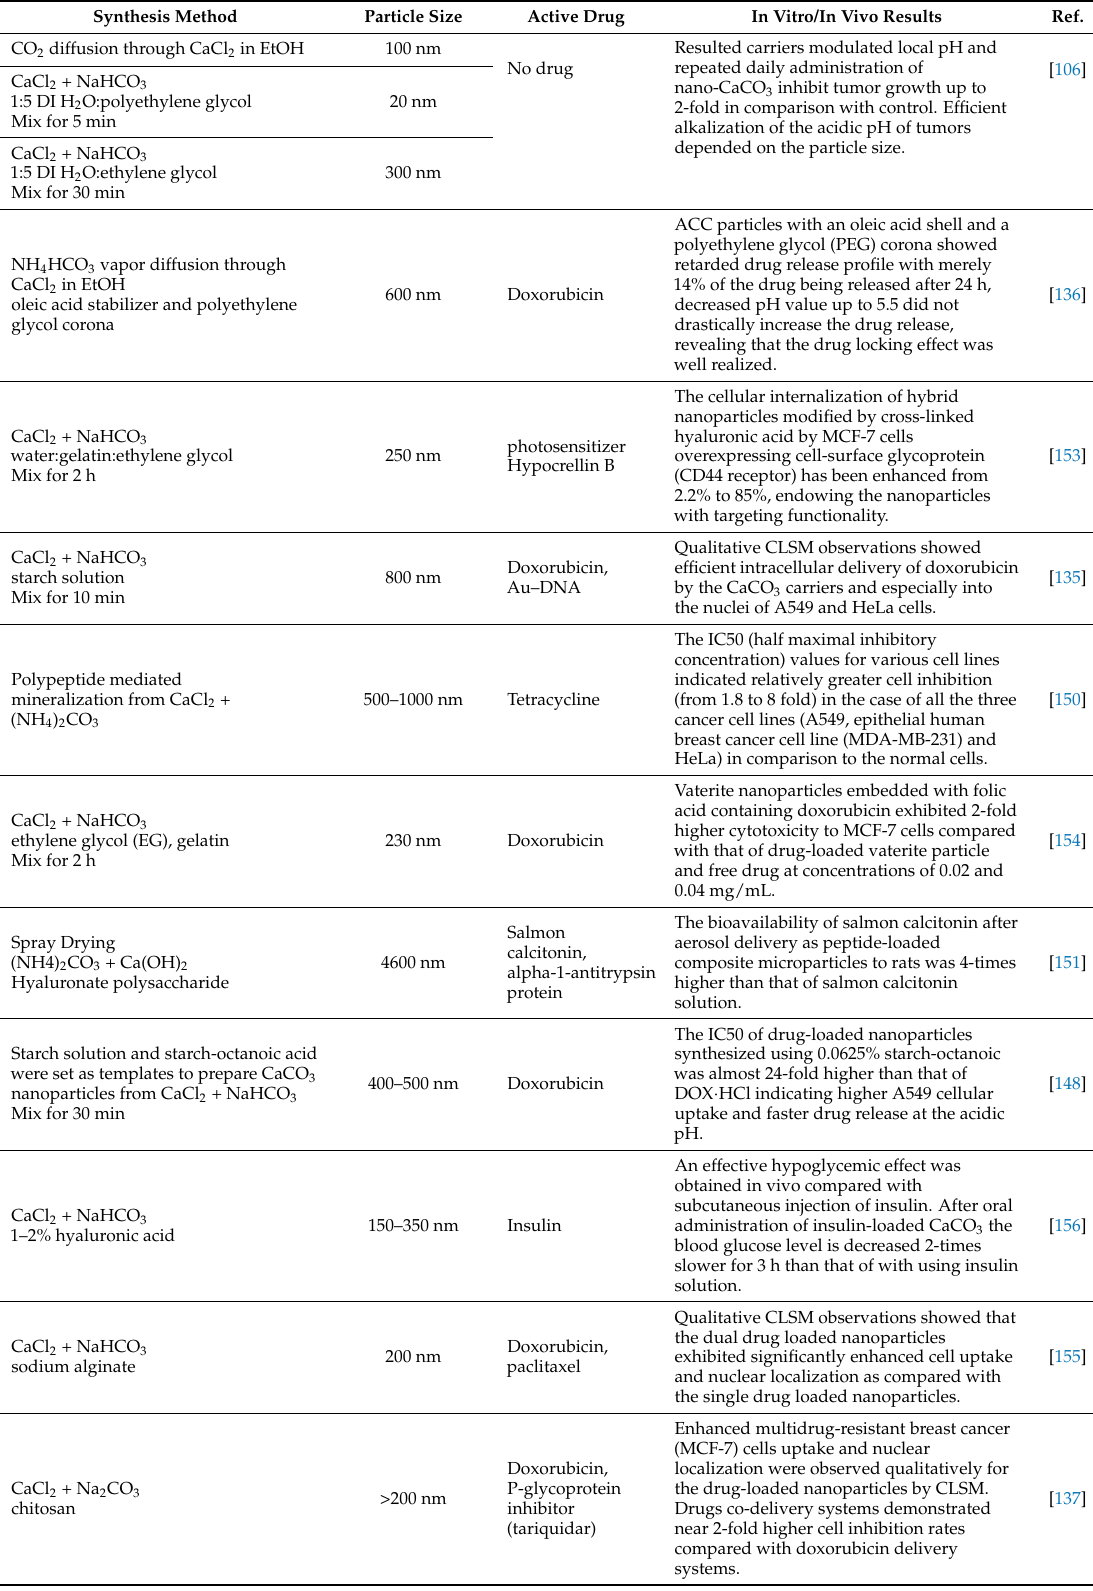
Table 2. Recently studied CaCO 3 drug delivery